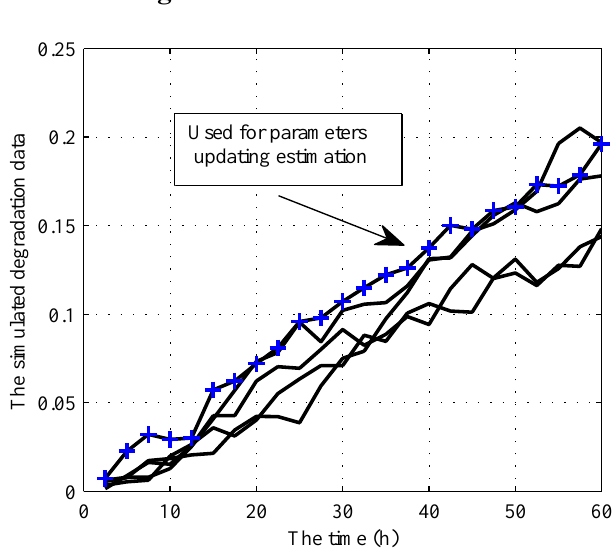
Figure 3. The simulated data.